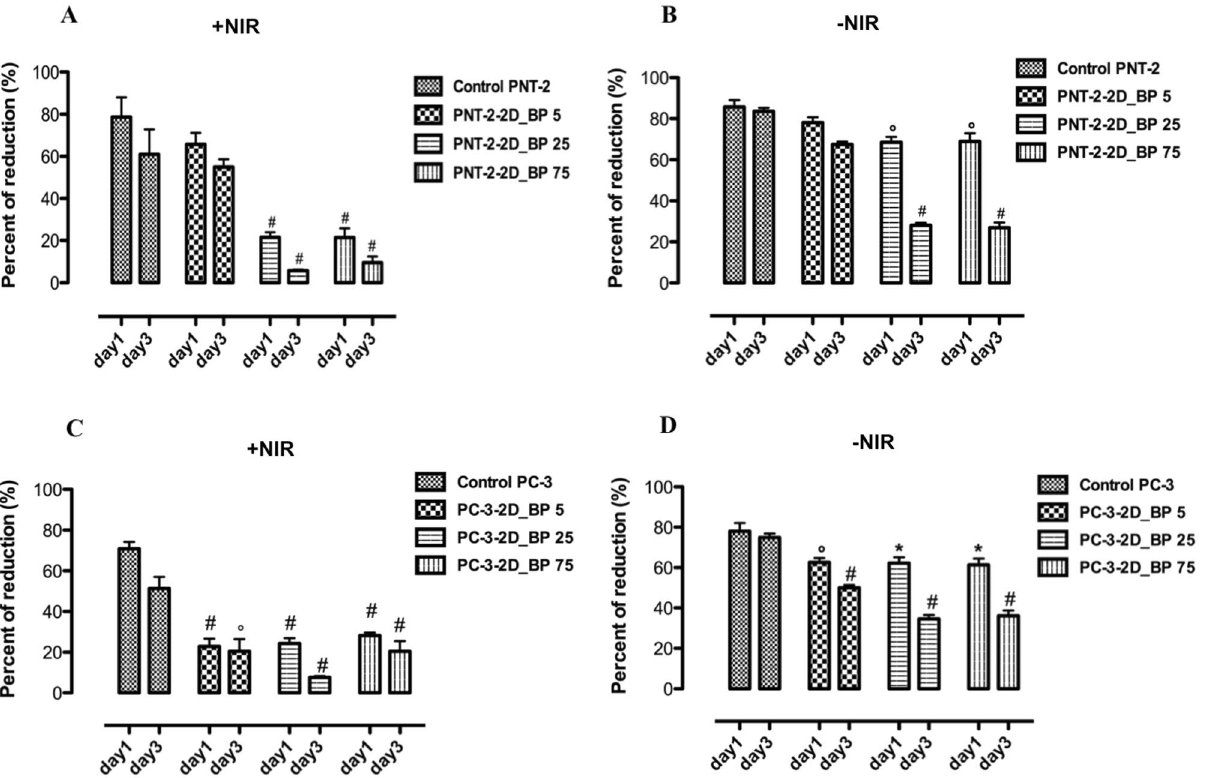
Figure 2. Effect of 2D BP on PNT-2 ( A , B ) and PC-3 ( C , D ) proliferation with and without infrared irradiation (NIR). The experiments performed on PNT-2 and PC-3 cell proliferation using Alamar Blue assay have shown that irradiated ( A – C ) and not irradiated ( B – D ) 2D BP (5 μg/mL) did not exert cytotoxic effects on PNT-2 and PC-3 after 1 and 3 days of exposure. The same result was obtained in presence of not irradiated 2D BP (25 μg/ mL) at day 1 of cell culture ( A ). Not irradiated 2D BP (75 μg/mL) at day 3 and irradiated 2D BP (25–75 μg/ mL) at all-time points significantly (° p ≤ 0.001; # p ≤ 0.0001) decreased cell viability of healthy prostatic cells (PNT-2) compared to control ( A , B ). Results are mean ± SEM of 3–4 experiments. The irradiated ( C ) and not irradiated ( D ) lowest concentration (5 μg/mL) of 2D BP induced a significant (° p ≤ 0.001; # p ≤ 0.0001) decrease in PC-3 (cancer cells) proliferation after 1 and 3 days of exposure compared to control. This effect results more significant in presence of irradiation ( A ). The best inhibition in PC-3 proliferation was obtained after 3 days of irradiated 2D BP exposure at concentration of 75 μg/mL # p ≤ 0.0001 ( A ). Results are mean ± SEM of 3–4